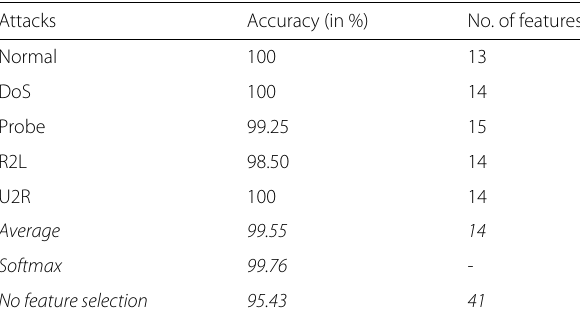
detection problem for each attack gets its own feature set. The threshold limit which selects the number of features versus overall accuracy of the system is shown in Fig. 5. It is basically comparing the performance of the model with respect to the number of features, since increasing the threshold score means considering less features and vice versa.